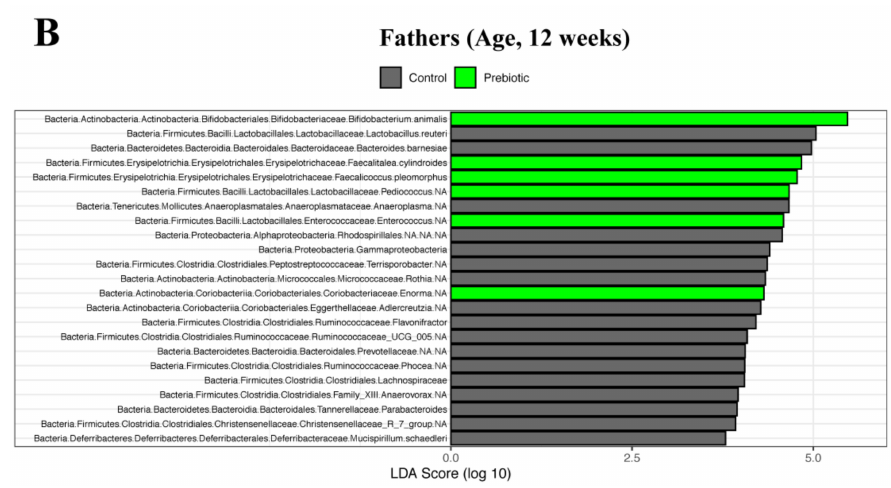
Figure 4. Fecal microbiota comparisons using a LEfSe tool of fathers fed prebiotic or control diet.